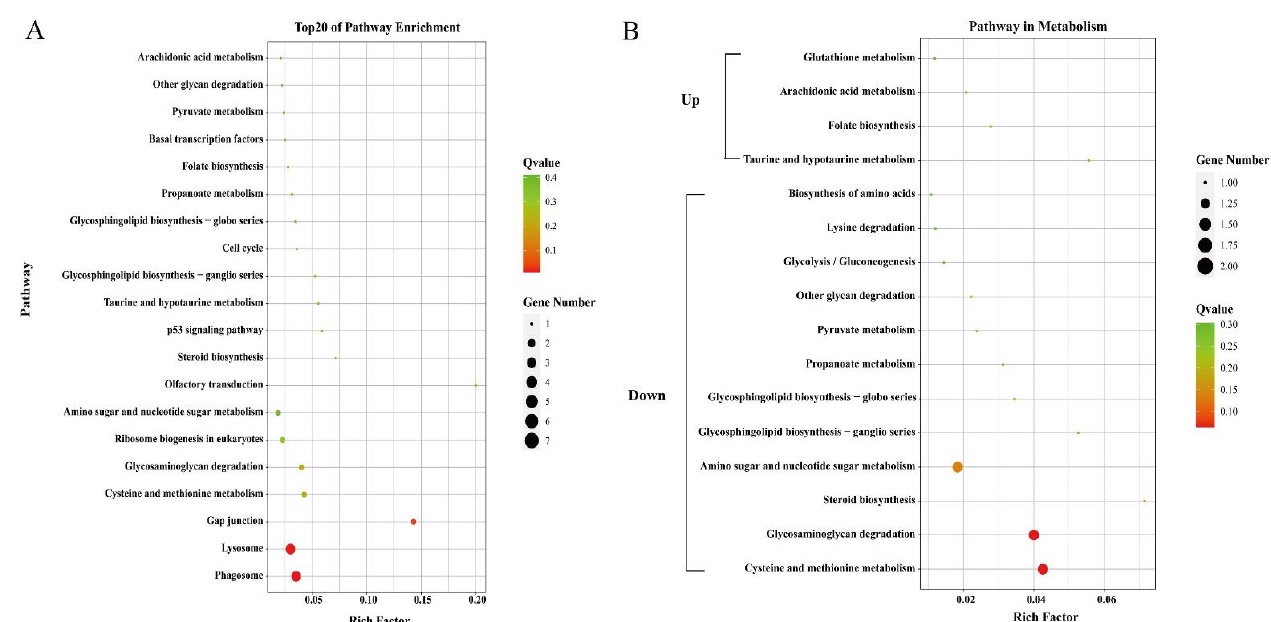
Figure 3. Top 20 enriched pathways ( A ) and pathways related to metabolism ( B ). The circle size and filled portions represented the number of differentially expressed genes in each pathway. The statistical significance was colored according to Q -values.